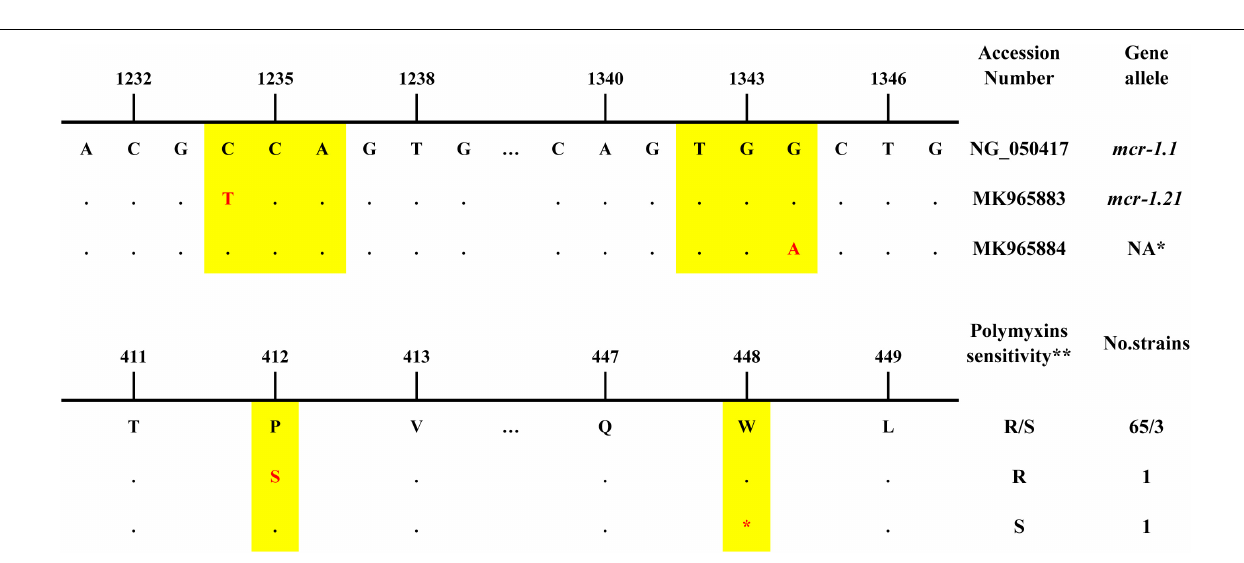
FIGURE 1 | Species and number of mcr-1 positive strains.